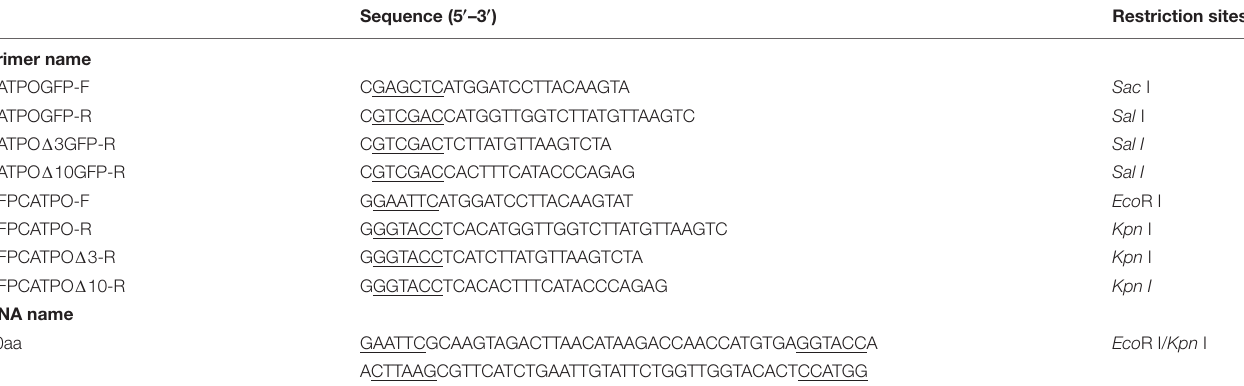
TABLE 1 | PCR primers and synthesized 10aa gene fragment used in this study.